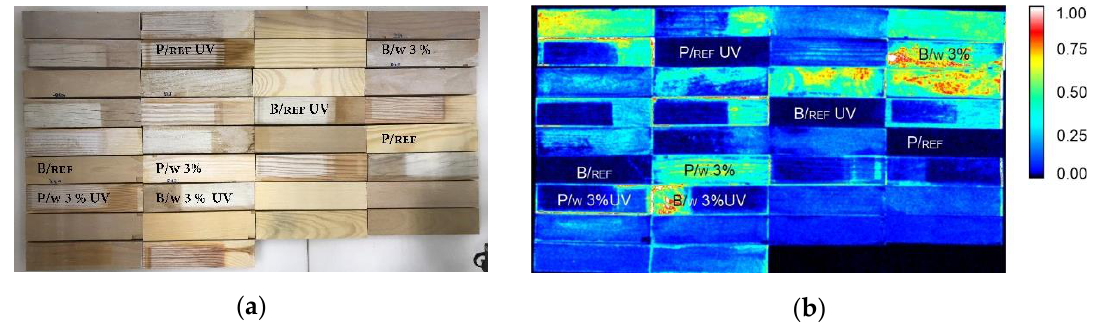
Figure 5. Set of specimens of beech wood (B) and pine wood (P)—uncoated (Ref) and coated with dispersions of TiO 2 in different concentrations (3%) in water (w), water glass, and acrylic, before and after UV light irradiation: ( a ) photo in visible light; ( b ) Ti X-ray intensity map.